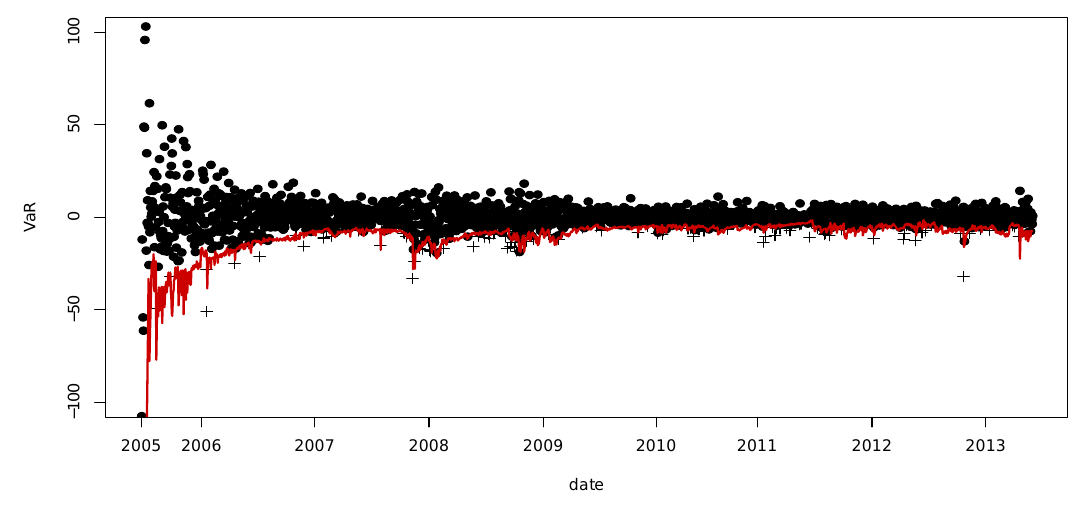
Figure 3: Exceedances plot for VaR ( α ) with α = 0.05 on the IBM-Google portfolio for the Patton (2006) model. The dots repre- sent the empirical portfolio value stated by the data, the “+” signs correspond to the exceedances.